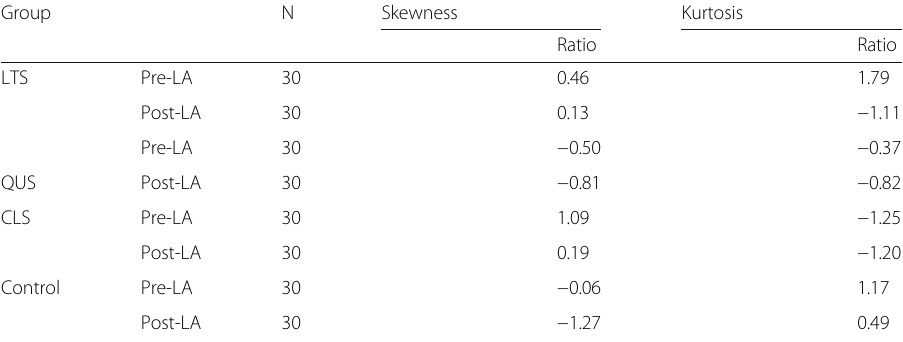
Table 2 Testing Normality Assumption Group